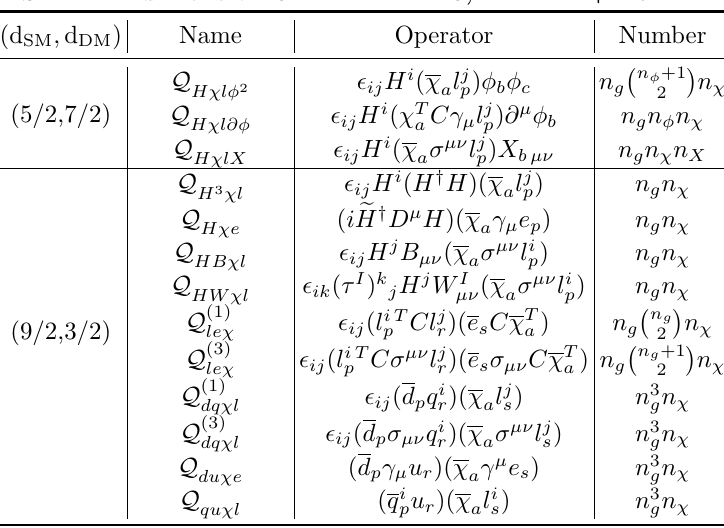
Table 15 . Dimension-six ∆ B = 0 , ∆ L = 1 operators in DSMEFT. The first column gives the dimensions of the SM and DM part of the operator, and the fourth column is the number of operators.